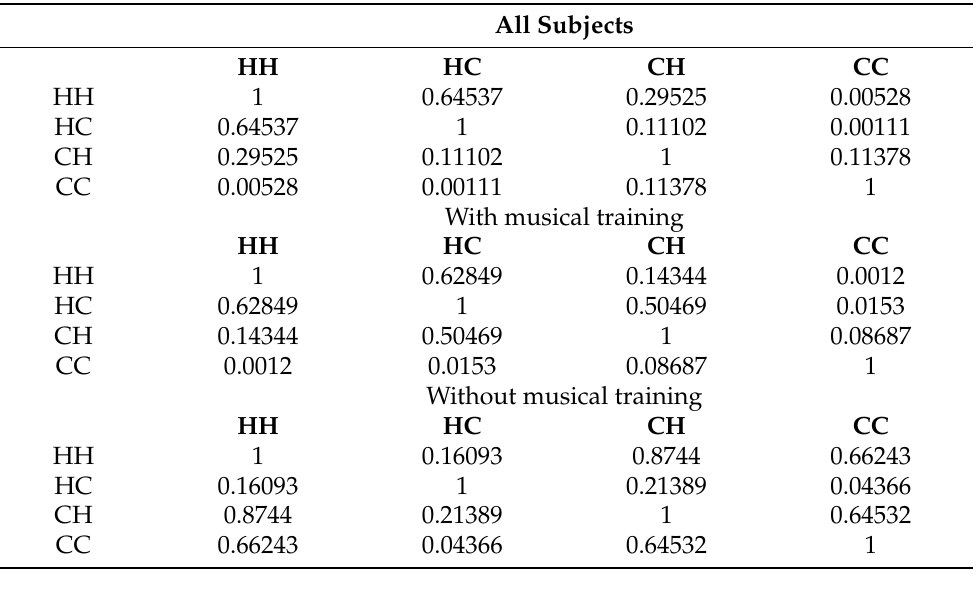
Table 4. Chi-squared test (with α = 0.05) comparing the perception of the composer as human or artificial among all the possible combinations of human/computer performer/composer. HH = music composed and performed by a human; HC = music composed by a human and performed by a machine; CH = music composed by a machine and performed by a human; CC = music composed and performed by a